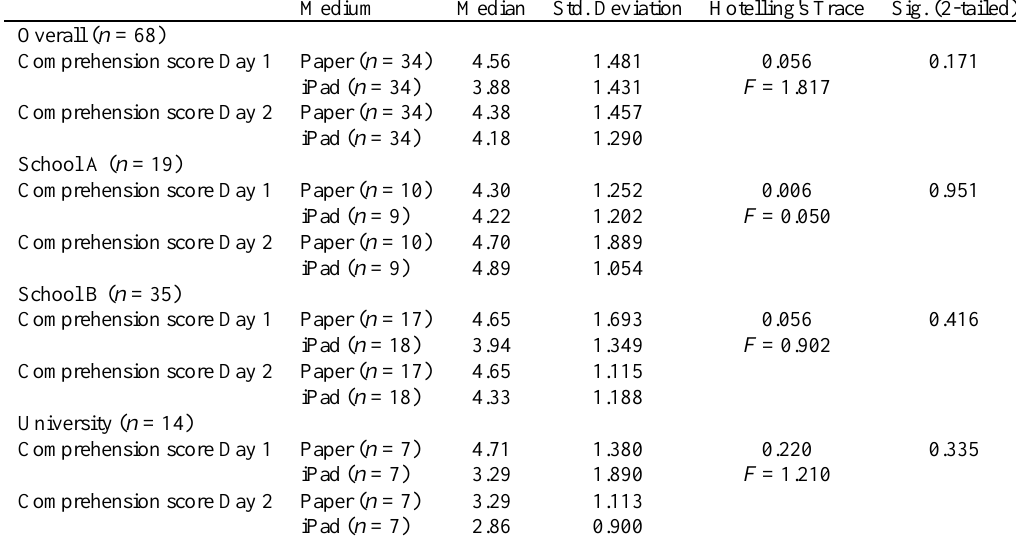
Table 6 Comprehension score with Multivariate Analysis